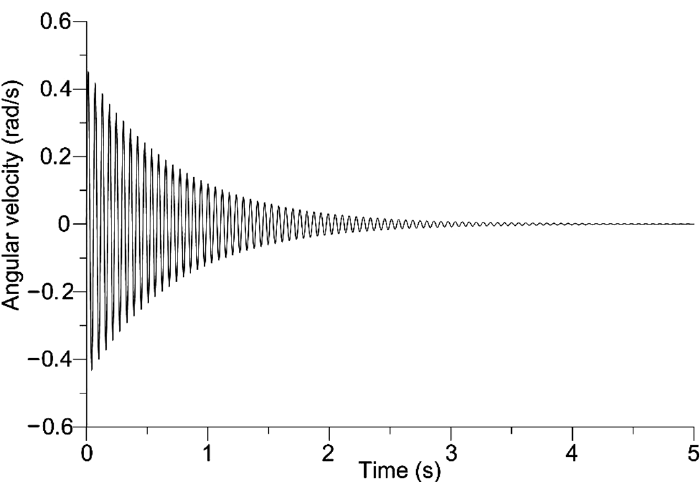
Figure 3. Instant angular velocity of the motion transmission left end for the first experiment.